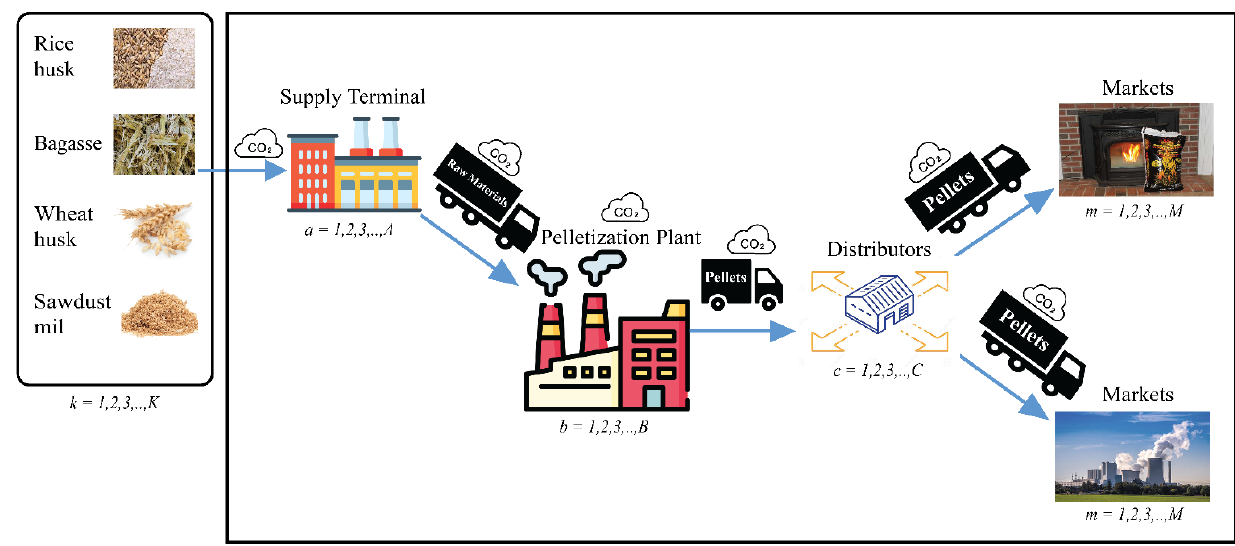
Figure 2. Working framework of WPP-SCND optimization model.